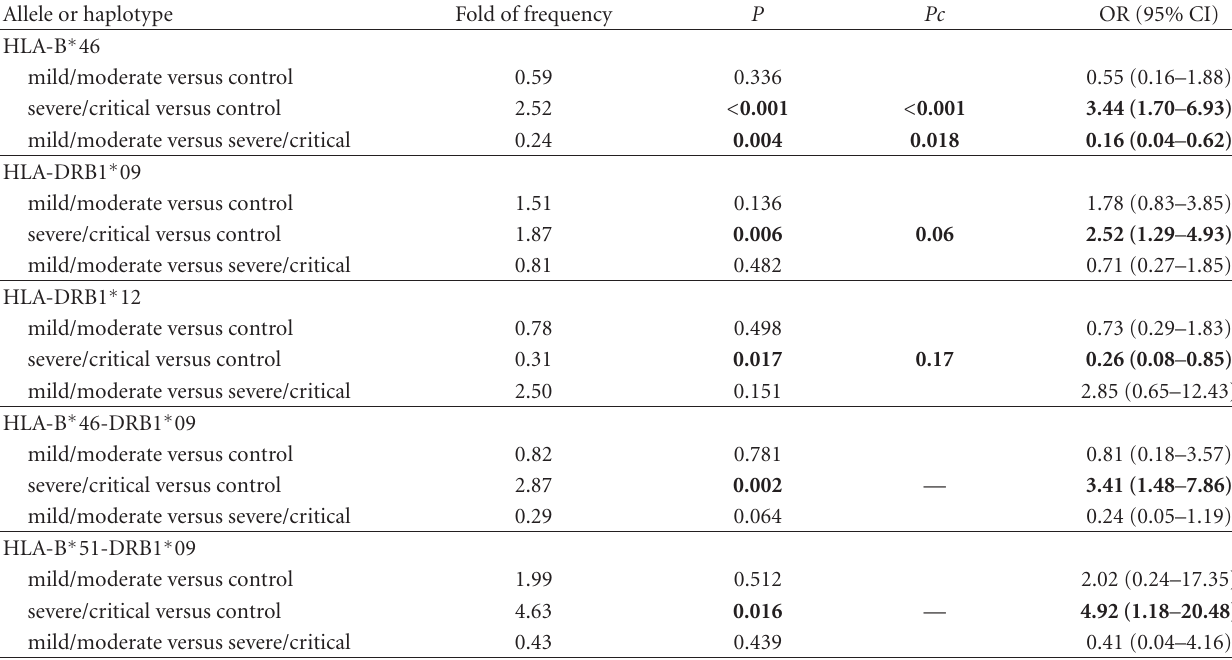
Table 5: The association between alleles or haplotypes and severity types in hemorrhagic fever with renal syndrome. Allele or haplotype Fold of frequency HLA-B ∗